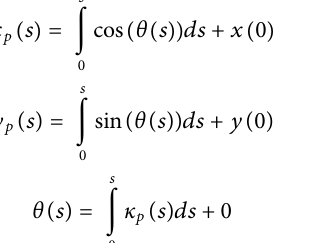
Frontiers in Robotics and AI |